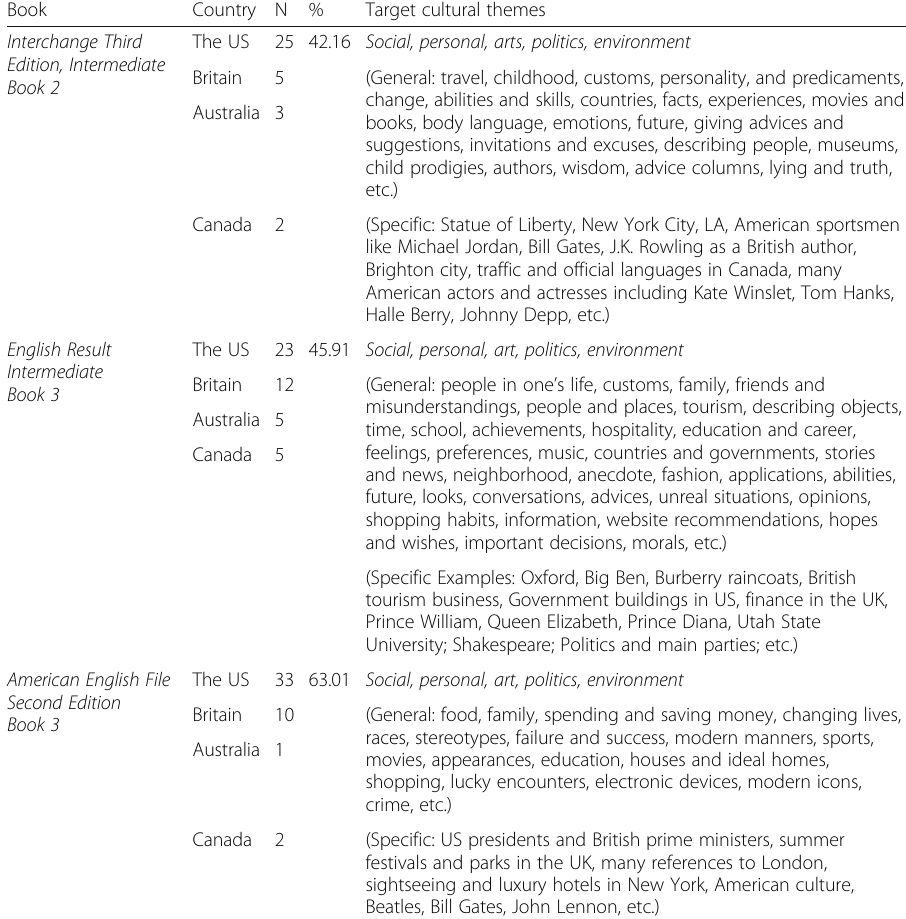
Table 1 Frequency of references to inner circle countries Book Country N % Target cultural